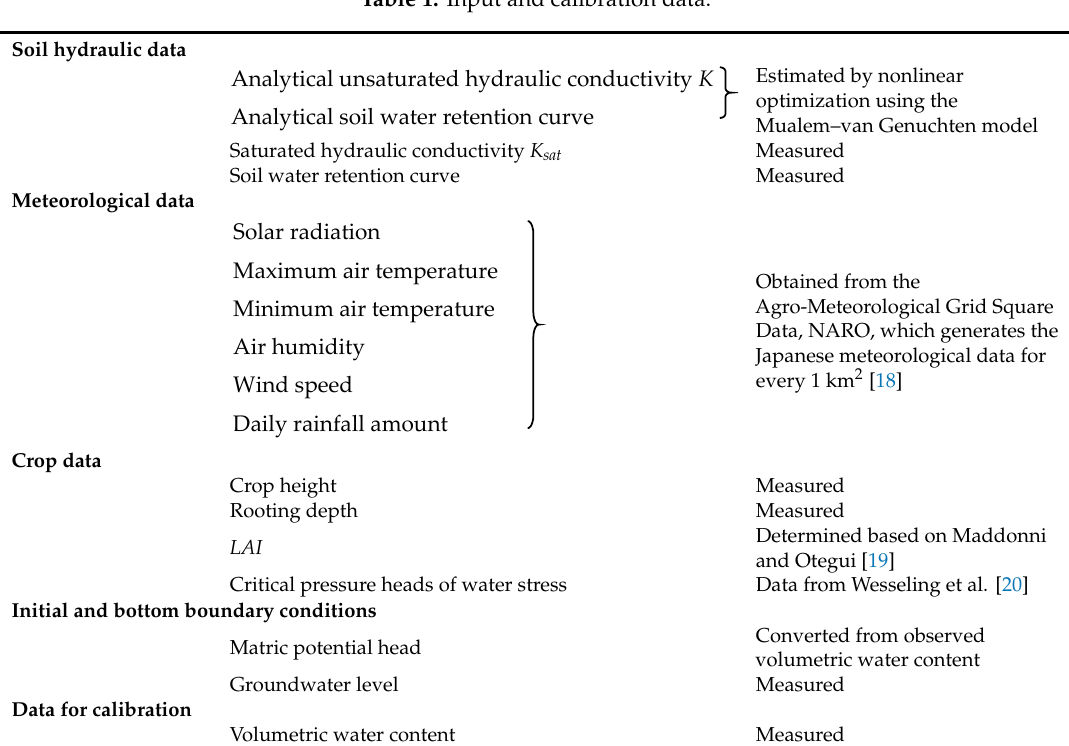
Table 1. Input and calibration data.